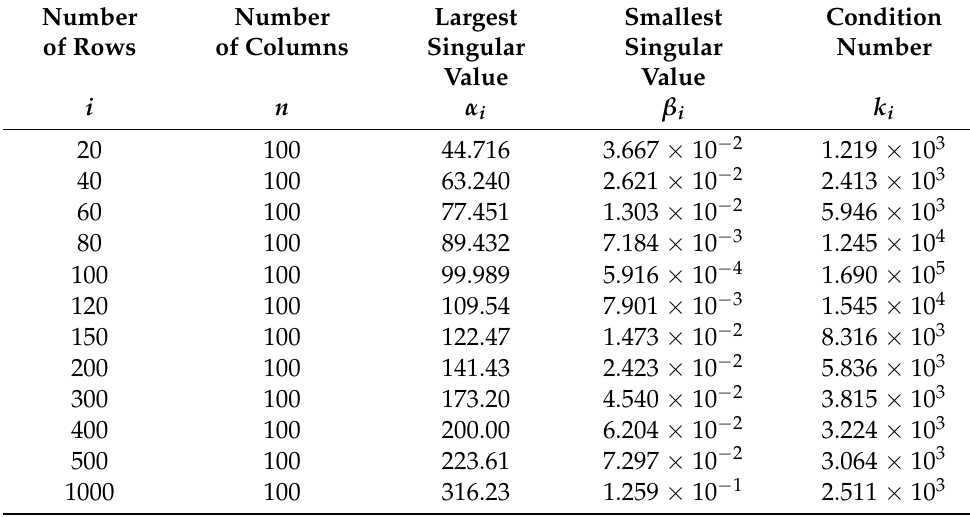
Table 9. The anomaly in random “narrow range”